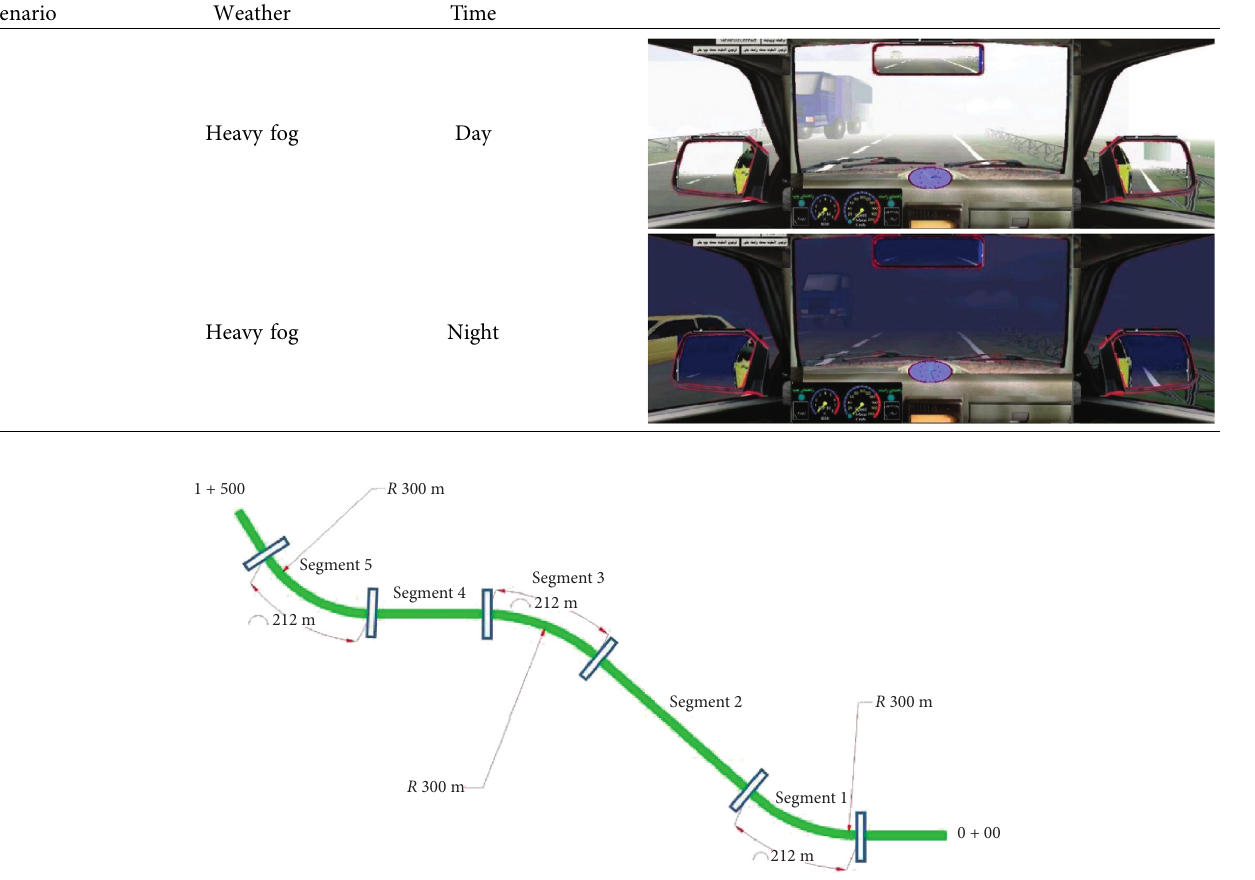
Figure 4: Plan view of the simulated road in the driving simulator with divisions related to each